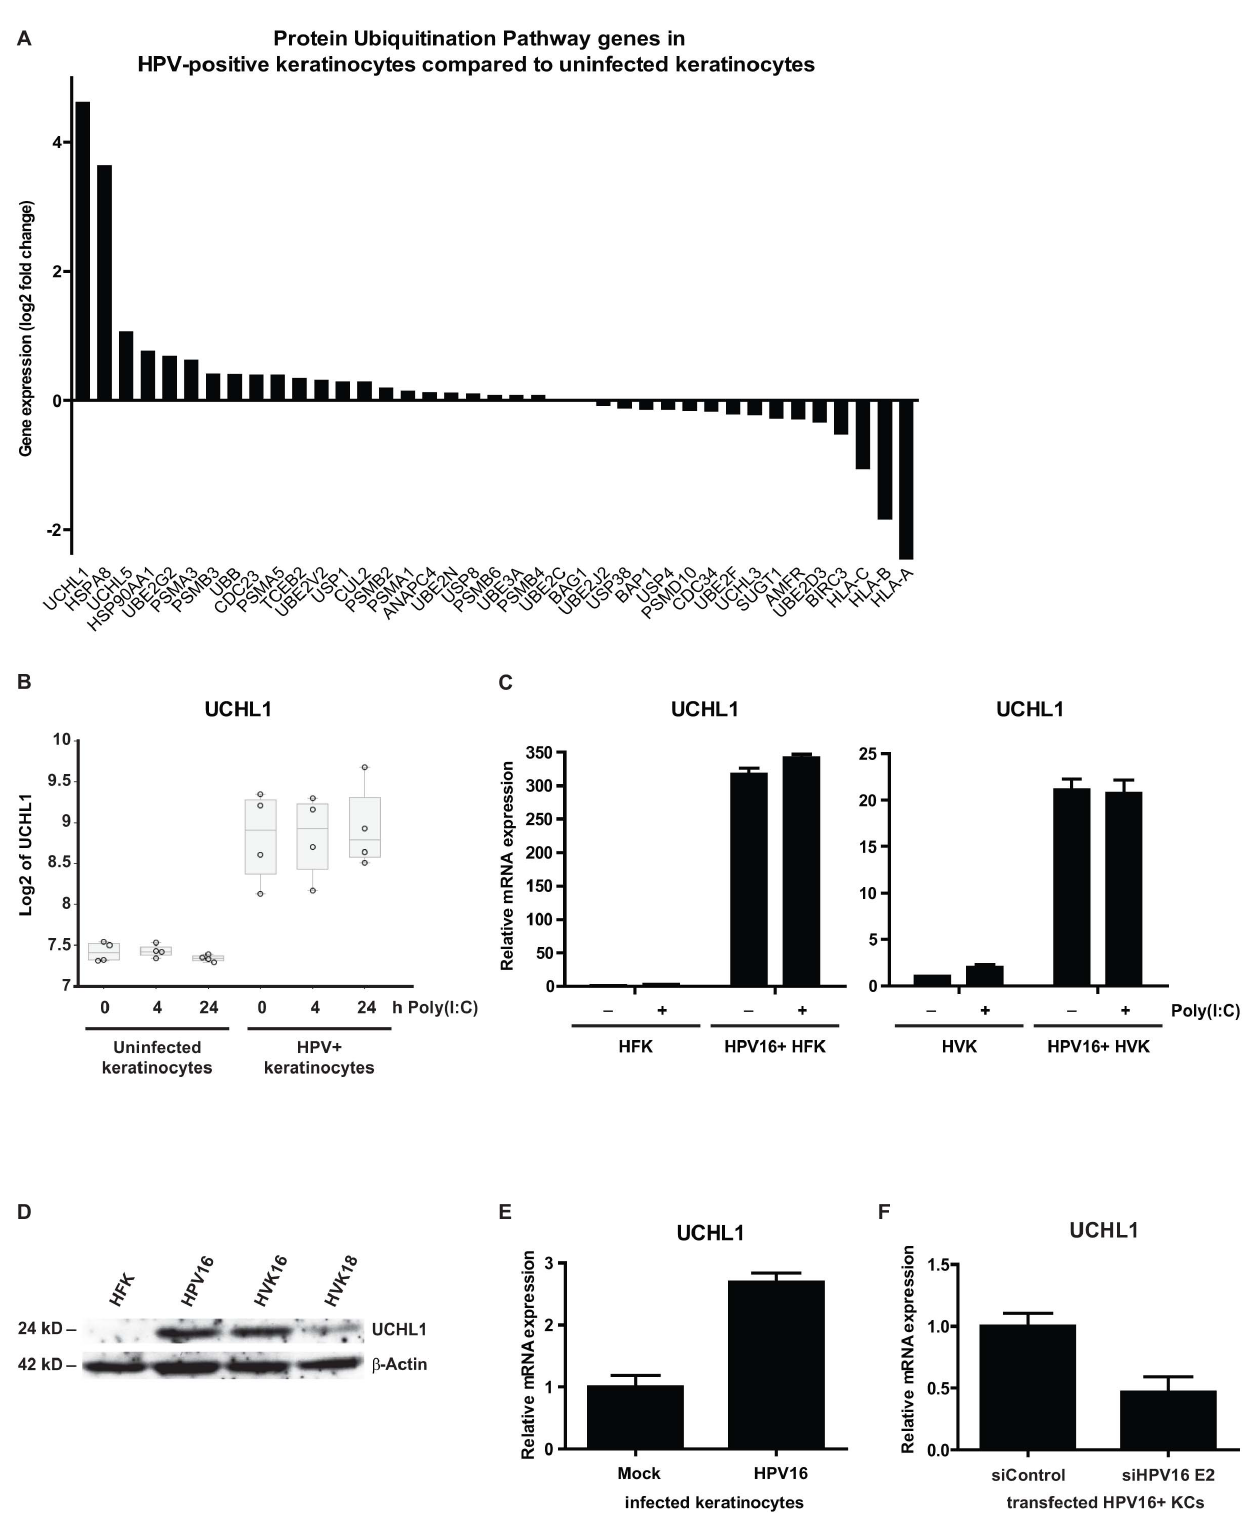
Figure 4. HPV induces expression of UCHL1 in keratinocytes. ( A ) Summary of all differentially expressed genes within the Protein Ubiquitination Pathway. Differentially expressed genes between four uninfected KC and four hrHPV + KC cultures with adjusted p -value # 0.05 identified 24 hours after poly(I:C) stimulation by microarray analysis (log2 ratios) are shown. ( B ) UCHL1 microarray gene expression values (log2 intensities) after 0, 4, and 24 hours of poly(I:C) stimulation in four primary KCs and four hrHPV + KCs (circles). The box represents the 25 th and 75 th percentiles, the median is indicated with a horizontal line within the box, and the whiskers represent the minimum and maximum. ( C ) UCHL1 expression in HPV16 + human foreskin keratinocytes (HFK; left panel) and HPV16 + human vaginal keratinocytes (HVK; right panel) when compared to uninfected KCs. KCs were either left unstimulated or stimulated with poly(I:C) for 24 hrs. UCHL1 expression was normalized against GAPDH . ( D ) UCHL1